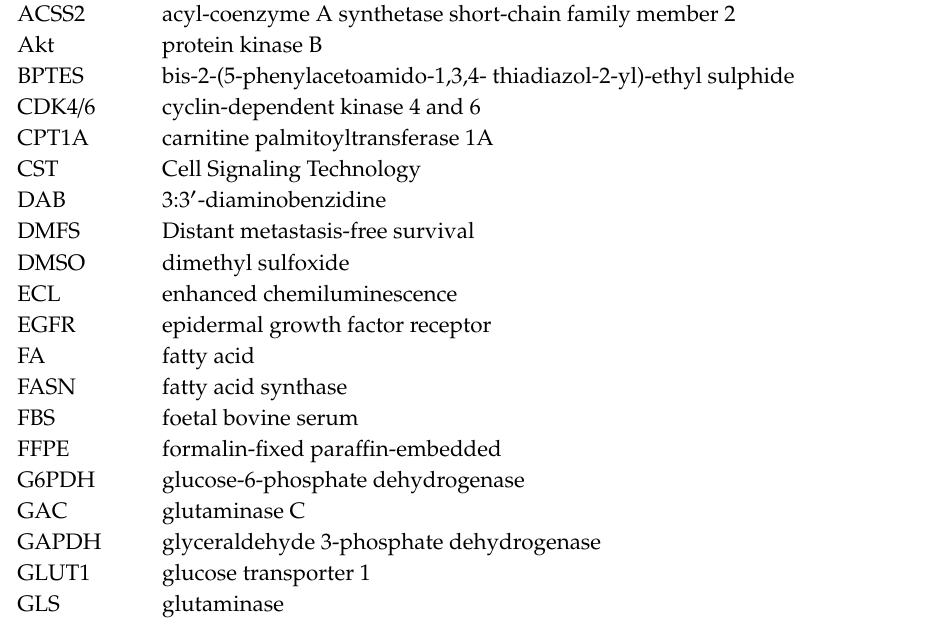
and SRB tests in human breast cancer cell lines. Table S2: KM-plotter meta-analysis of mRNA expression and clinicopathological data from breast cancer studies. Table S3: List of breast cancer cell lines, including their IDs, most important mutations and subtypes. Table S4: List of the applied mTOR and metabolic inhibitors. Table S5: List of primary antibodies used for Western blotting and